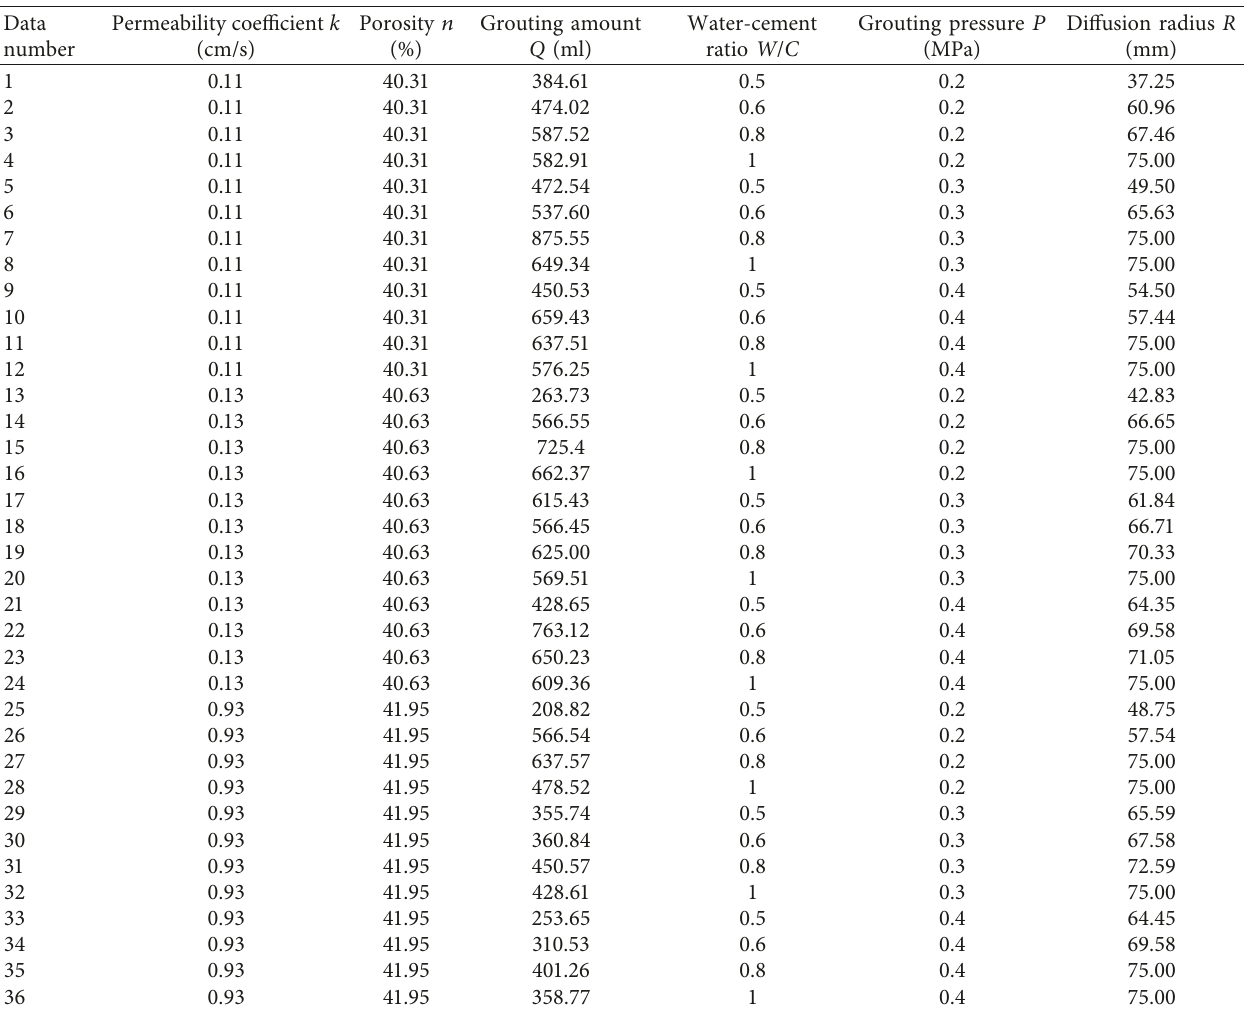
Table 3: Statistics of grouted concretion test data.